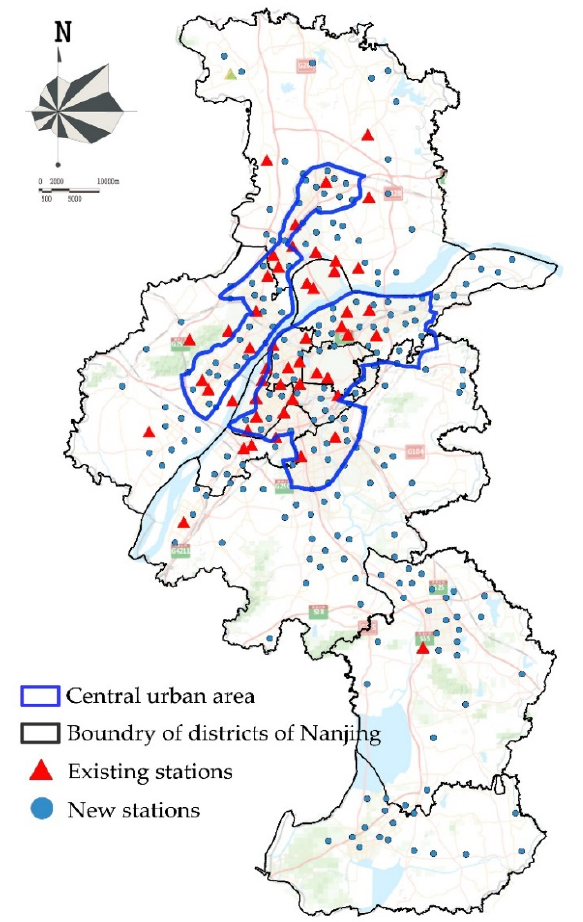
Figure 11. The final layout of fire stations.